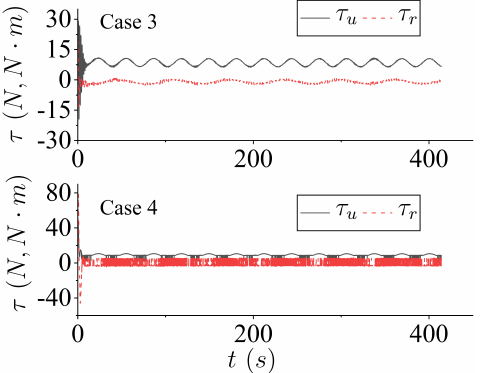
Figure 10. The control inputs in Case 3 and Case